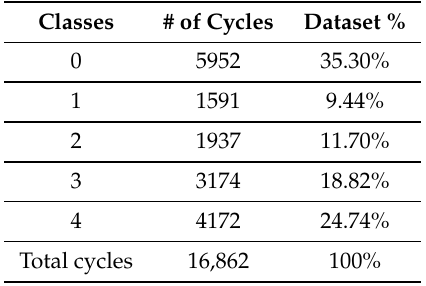
Figure 4. Samples of electricity consumption for different tensioning values. Table 1. Tension level dataset.